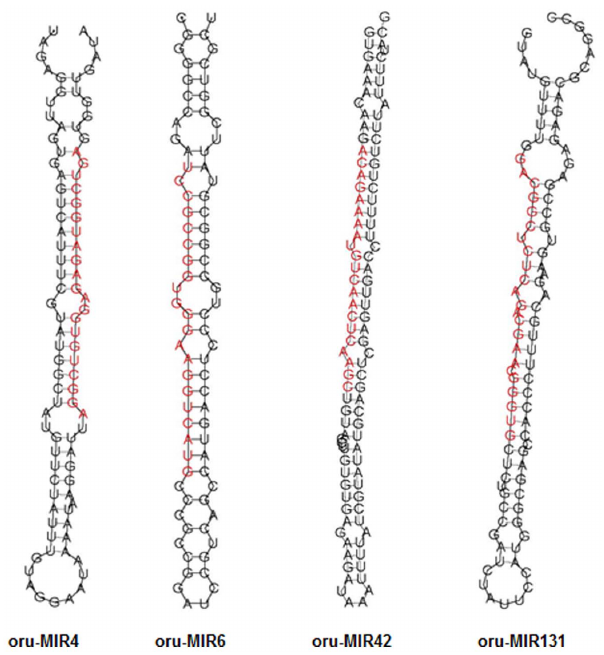
Figure 2. Examples of stem-loop hairpin secondary structures of predicted new miRNA precursors. Segments corresponding to the mature miRNAs are shown in red.